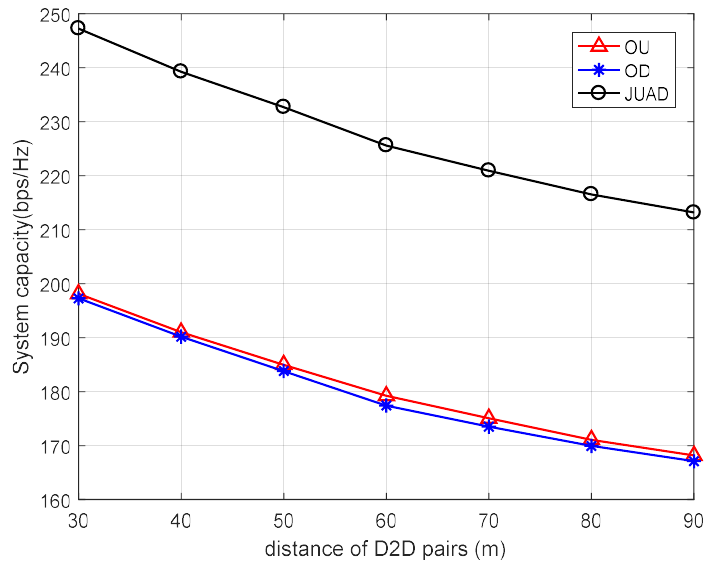
Figure 6. The system capacity with different distance of D2D pairs, comparison of the JUAD/OU/OD resource allocation schemes.